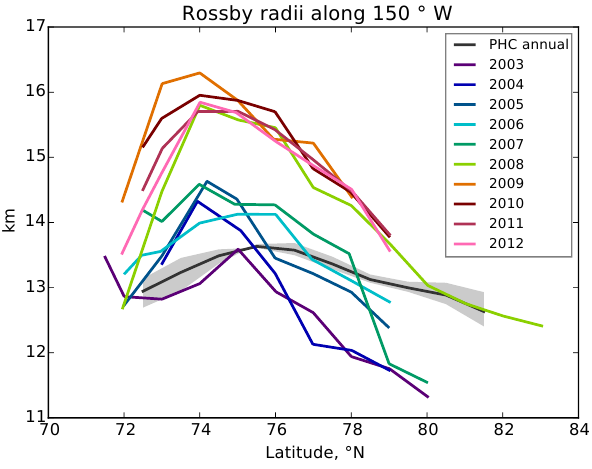
Figure 4. Rossby radius mode 1 (km) along BGEP 150 ◦ W hydro- graphic section for 2003–2012; years are identified by colour in the key. PHC values along 150 ◦ W are shown in black, with grey shad- ing showing the seasonal range.